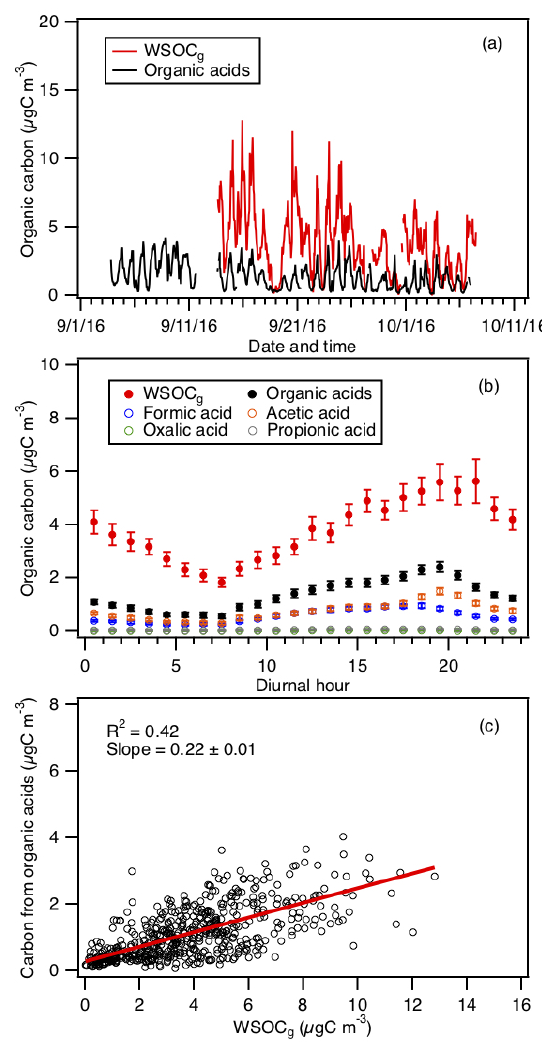
Figure 6. (a) Time series of WSOC g and the total organic carbon contributed by formic, acetic, oxalic and propionic acids. All the data are displayed as 1h averages. (b) Diurnal profiles of WSOC g and the total organic carbon contributed by formic, acetic, oxalic and propionic acids. Also shown are the diurnal profiles of the or- ganic carbon contributed by the individual organic acids. All the concentrations represent the mean hourly averages and the standard errors are plotted as error bars. (c) Scatter plot of total organic car- bon contributed by formic, acetic, oxalic and propionic acids with WSOC g